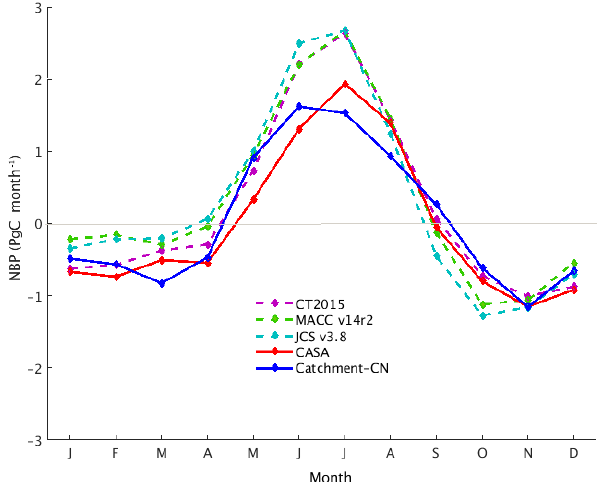
Figure 3. Monthly mean of terrestrial NBP of the Catchment-CN model (blue), of the CASA GFED3 model (red) and of three at- mospheric inversions (dotted lines), for the period of 2004–2014. Positive (negative) NBP values indicate that land is a carbon sink